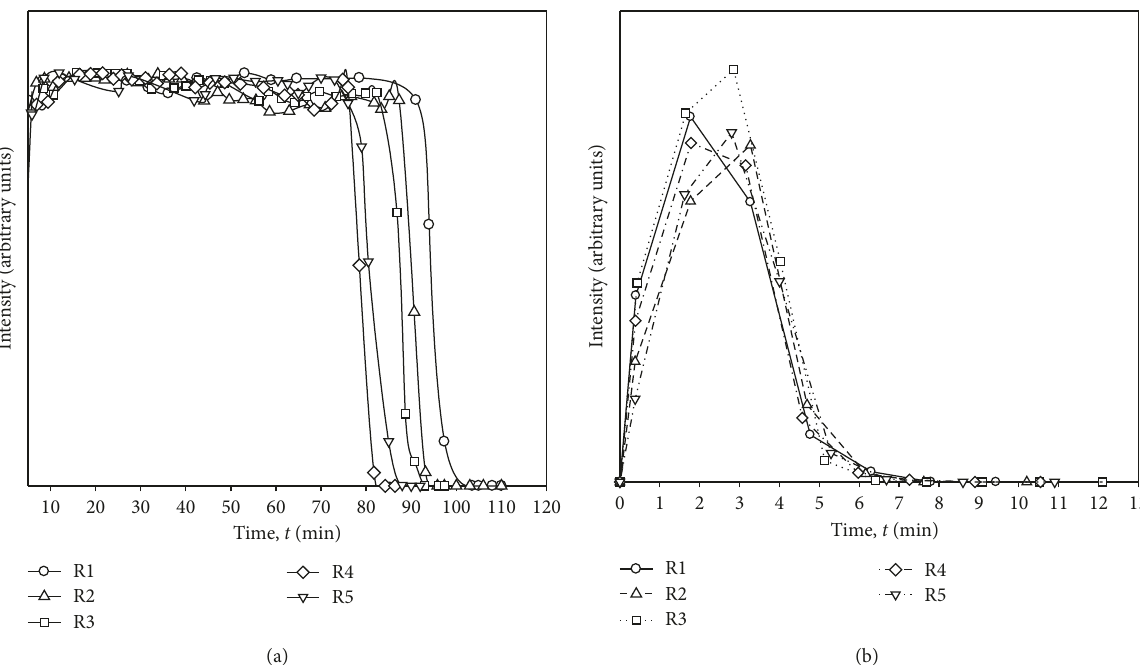
Figure 1: Evolution of SO 2 as a function of time using (a) diluted 1% O 2 and (b) air at 500